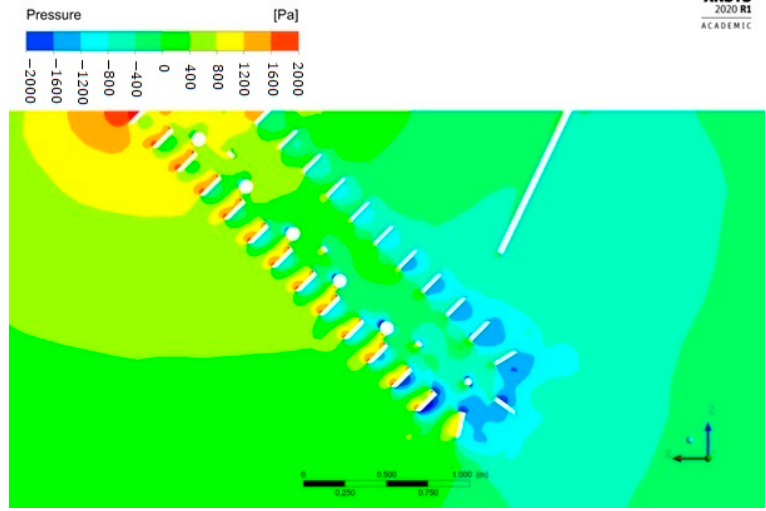
Figure 9. Top view of the velocity profile, 1 m under the top surface.